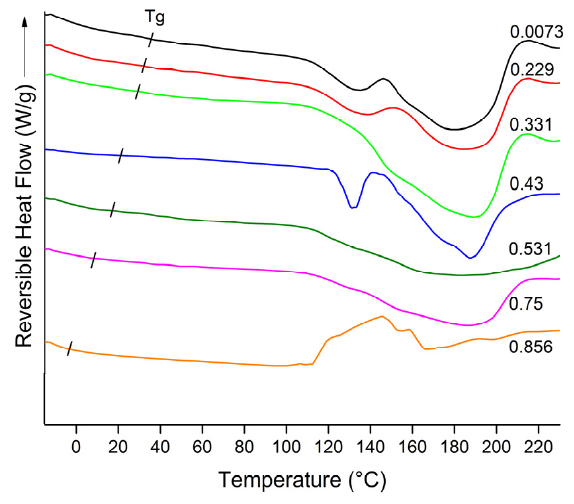
Figure 5. Reversible heat flow curves of the functional food blend MX-IN:25-75 at the different a w .